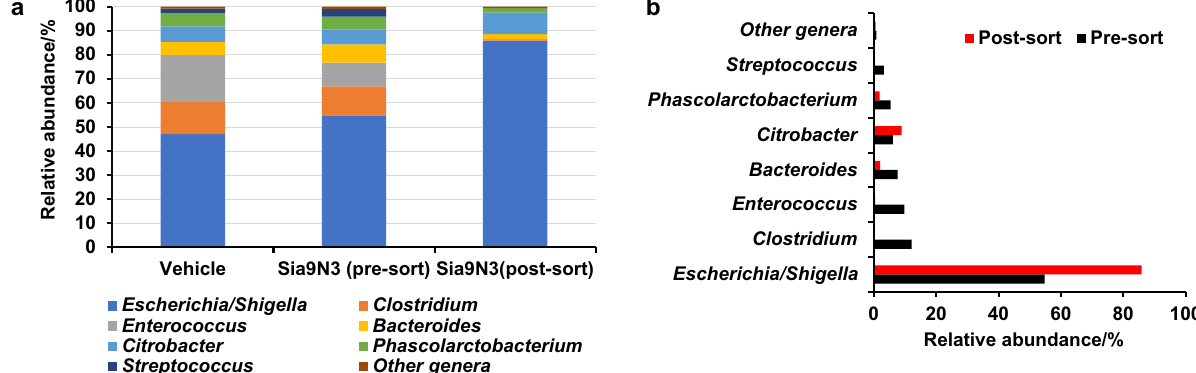
Figure 4. 16S rRNA gene sequencing analyses. ( a ) H2 microbiome sample was cultured with or without 200 μM